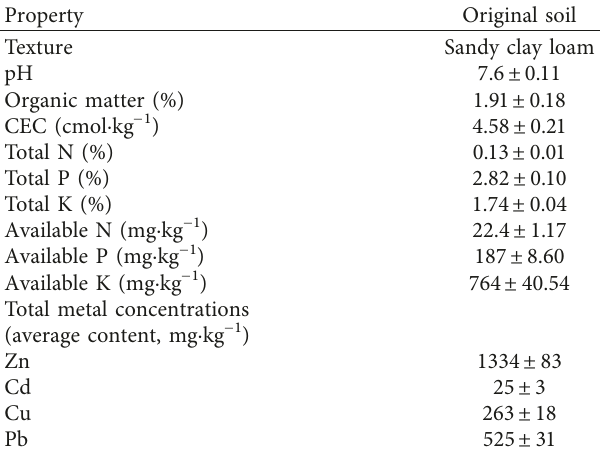
Table 1: The brief description of contaminated soil used in this study.